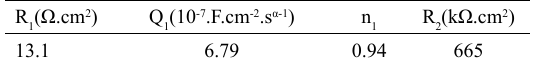
Figure 6. EEC used to simulate the experimental EIS data. Table 2. EIS fitting parameters for the AISI 409 stainless steel after immersion for one hour in 0.1 M NaCl solution at room